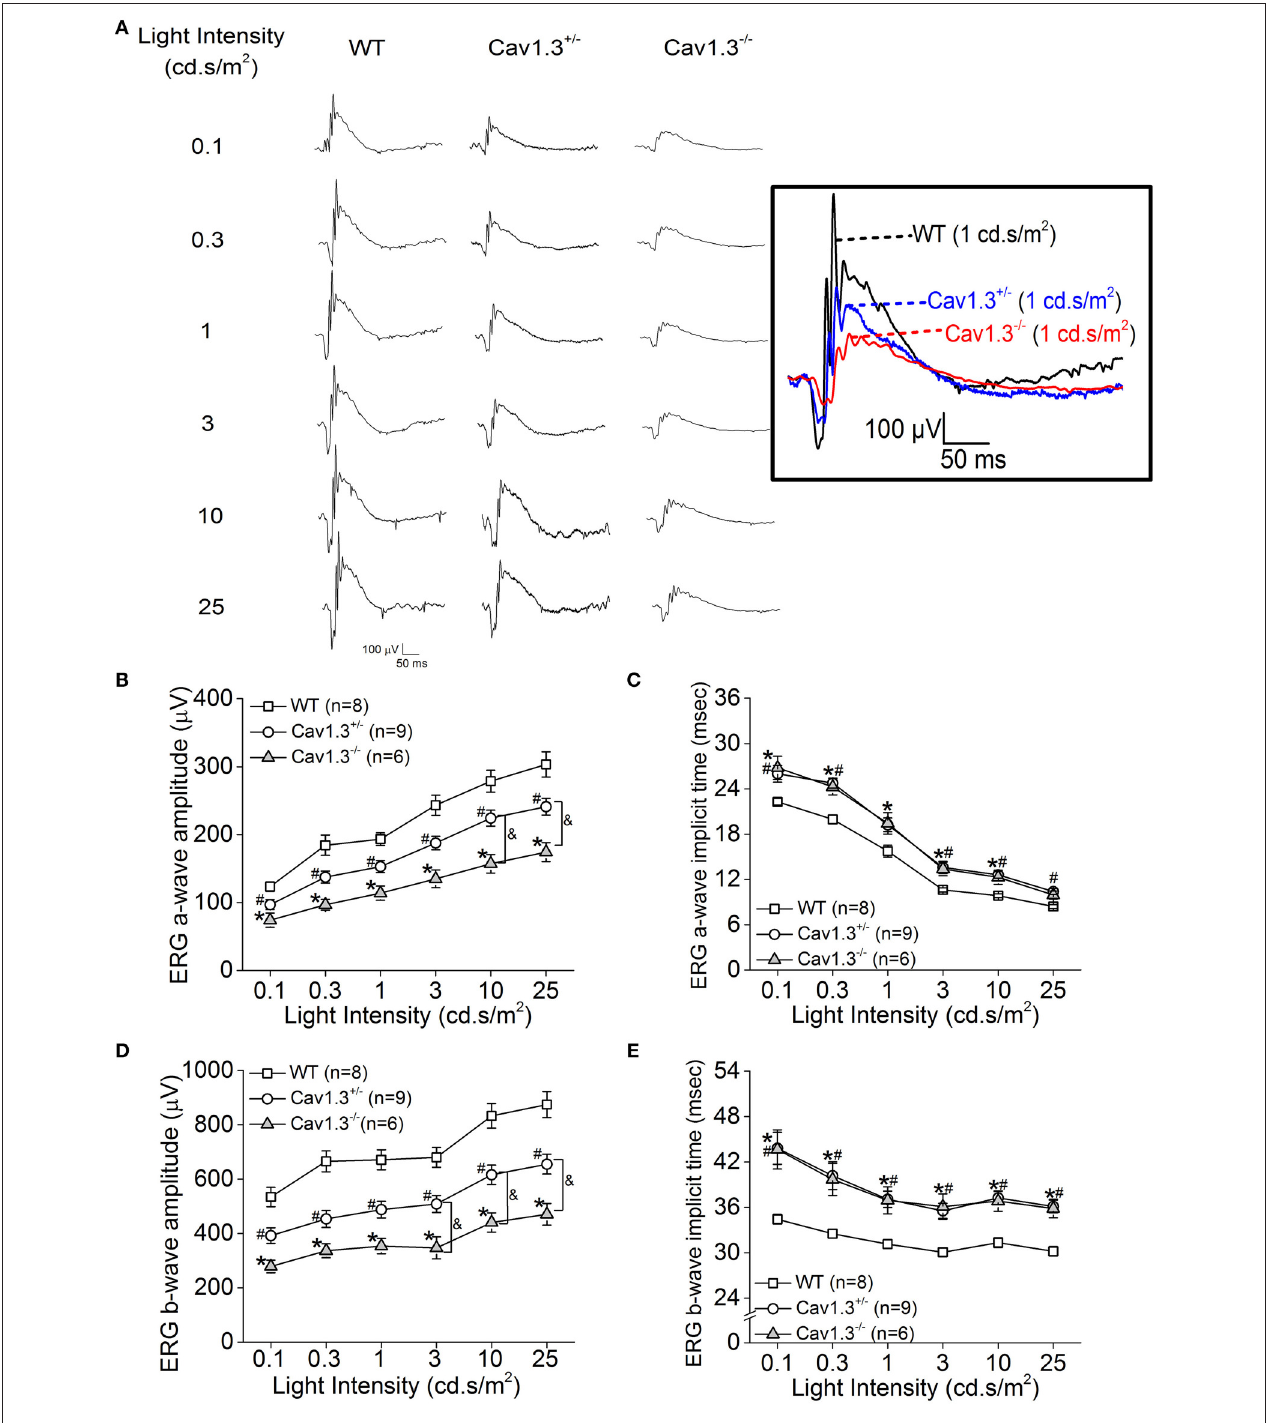
FIGURE 4 | Retinal light responses are decreased in Ca v 1.3 + / − and Ca v 1.3 − / − mutant mice. The scotopic ERG amplitudes are decreased and implicit times delayed in both Ca v 1.3 + / − (heterozygous mutant) and Ca v 1.3 − / − (homozygous mutant) mice compared to the wild type (WT) mice. All mice were dark adapted for at least 8h. Retinal light responses were measured when mice were exposed to a series of light intensities from 0.1 to 25 cd · s/m 2 . (A) Representative ERG wave forms recorded from WT (left), Ca v 1.3 + / − (middle), and Ca v 1.3 − / − (right) mouse eyes in response to each stimulating light intensity. The superimposed ERG traces from the WT (black), Ca v 1.3 + / − (blue), and Ca v 1.3 − / − (red) mice elicited at 1cd.s/m 2 light intensity are shown in the box. (B) The average ERG a-wave amplitudes are decreased in Ca v 1.3 + / − and Ca v 1.3 − / − mice compared to the WT. (C) The average ERG a-wave implicit times are increased in Ca v 1.3 + / − and Ca v 1.3 − / − mice compared to the WT. (D) The average ERG b-wave amplitudes are decreased in Ca v 1.3 + / − and Ca v 1.3 − / − mice compared to the WT. (E) The average ERG